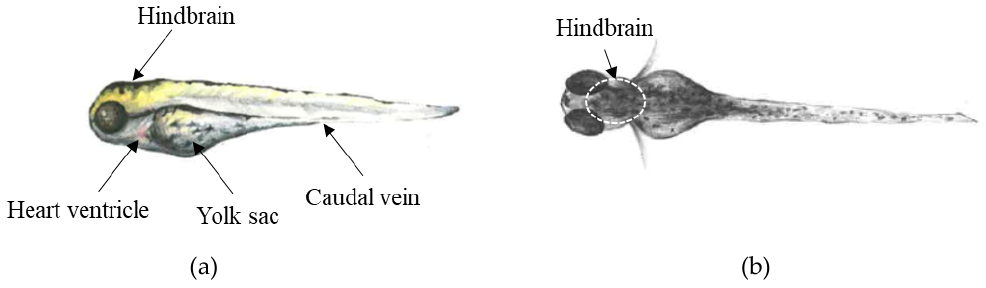
Figure 9. Microinjection sites used to administer 7′ N -5F-ADB to 4 dpf ZF larvae in ( a ) lateral and ( b ) dorsal view.